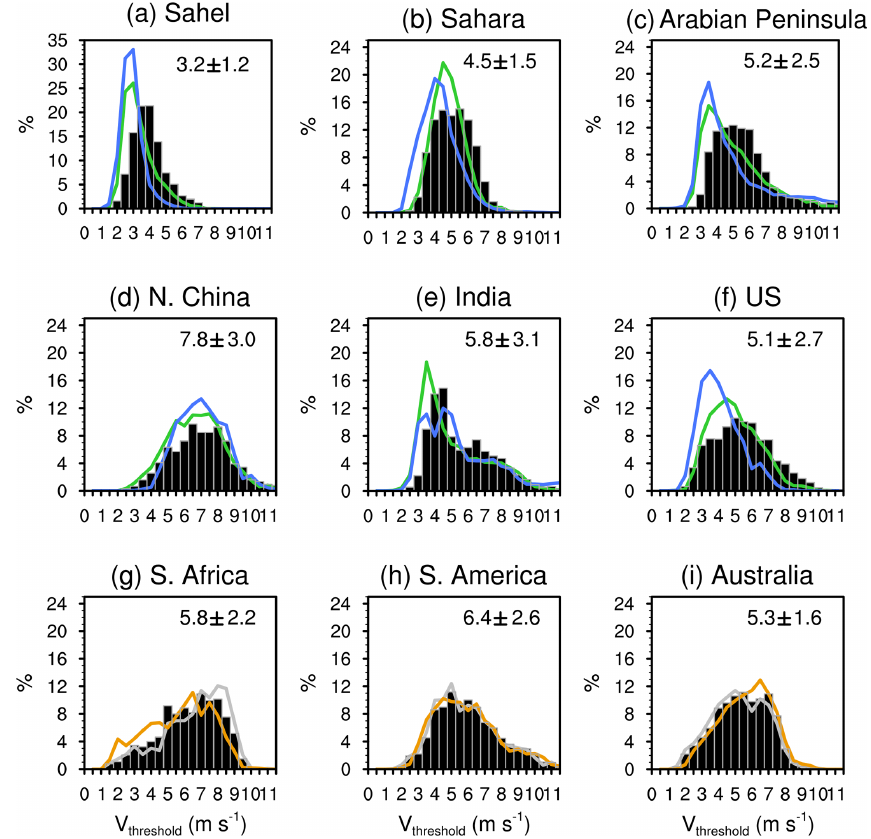
Figure 2. (a–i) Frequency distribution of annual mean V threshold (black bars) in each region (black boxes in Fig. 1) and V threshold for dusty seasons, i.e., MAM (green) and JJA (blue) for regions in the Northern Hemisphere and SON (orange) and DJF (grey) for regions in the Southern Hemisphere. The mean (averaged over all grid points in the region, without area weight) and ± 1 standard deviation of V threshold in each region are shown on the top right of each